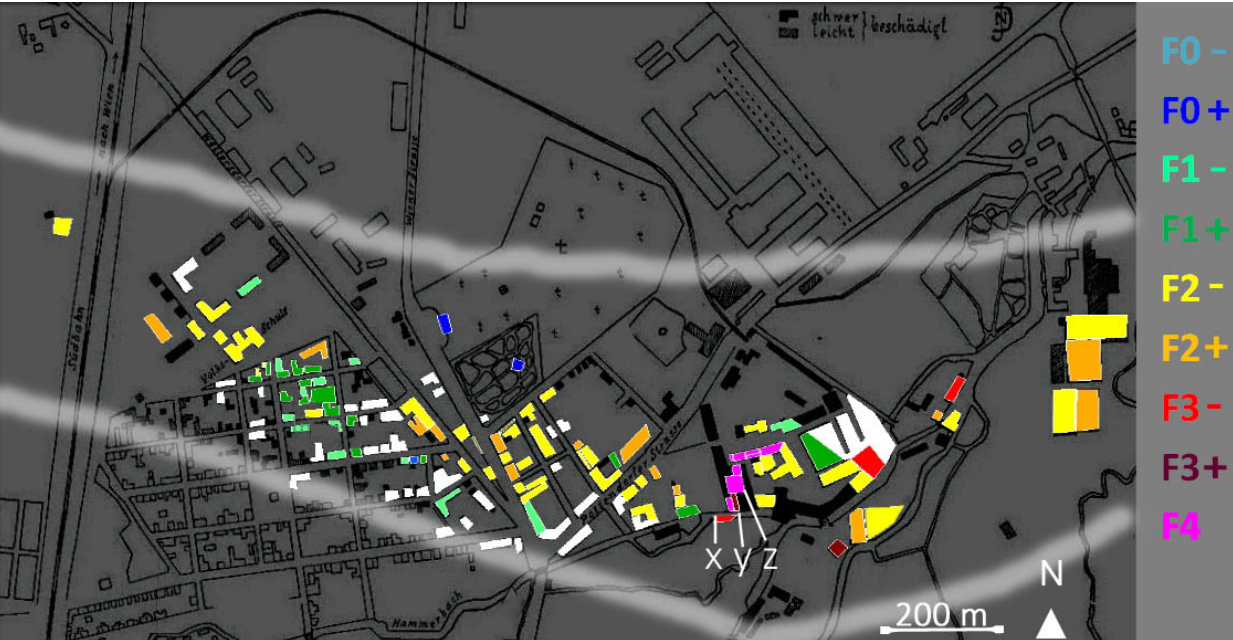
Figure 6. Damage map of urban Wiener Neustadt area. Colored shading represents new findings with corresponding scale values given to the right. White filling means that damage was seen on imagery, but an intensity rating was not possible. Soft white boundaries mark southern and northern edges of damages (drawn with manual interpolation). Background map: historic city map (Dörr, 1917). Buildings shaded in dark grey have shown minor damage ( leicht beschädigt ), buildings shaded in black have shown major damage ( schwer beschädigt ) in the historical damage